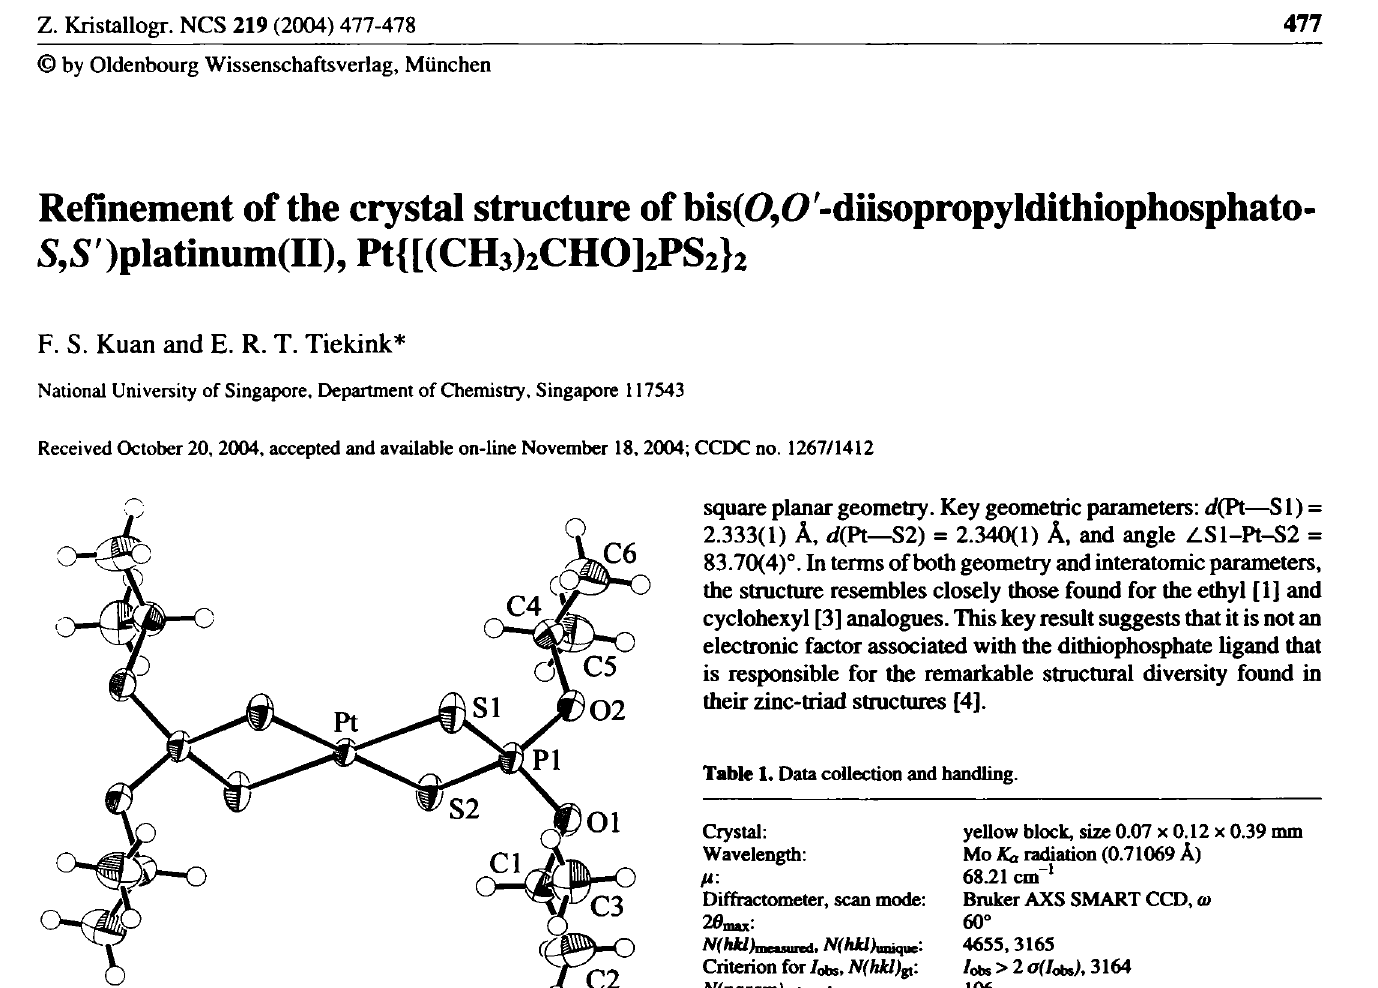
Ci2H2804P2PtS , triclinic, PI (no. 2), a = 6.3121(8) A, 4 b = 8.424(1) A,c = 10.904(1) A, a = 100.322(2)°, P = 96.640(3)°, y = 98.788(2)°, V = 557.6 A 3 , Z = 1,